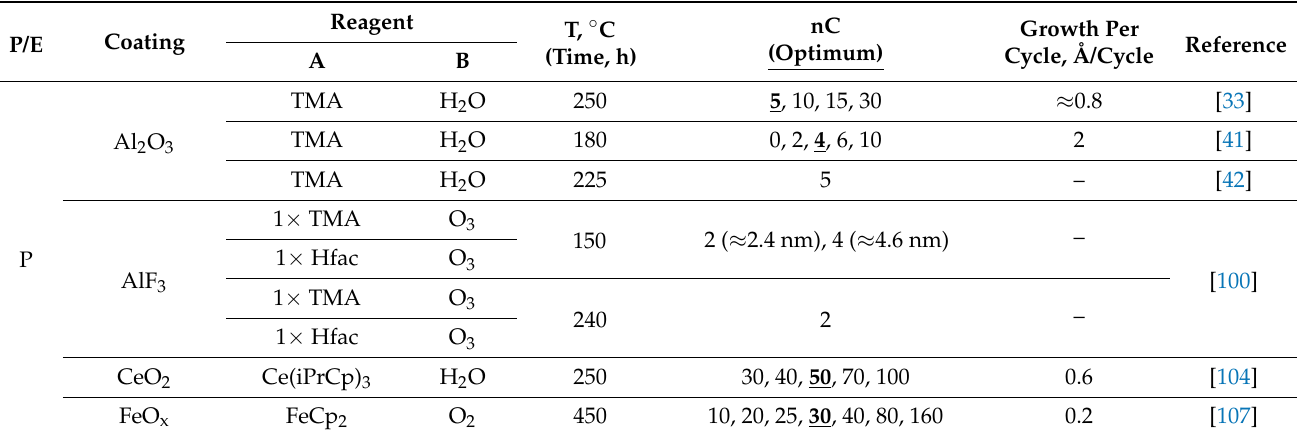
Table 4. Main parameters of LNMO (LiNi 0.5 Mn 1.5 O 4 )